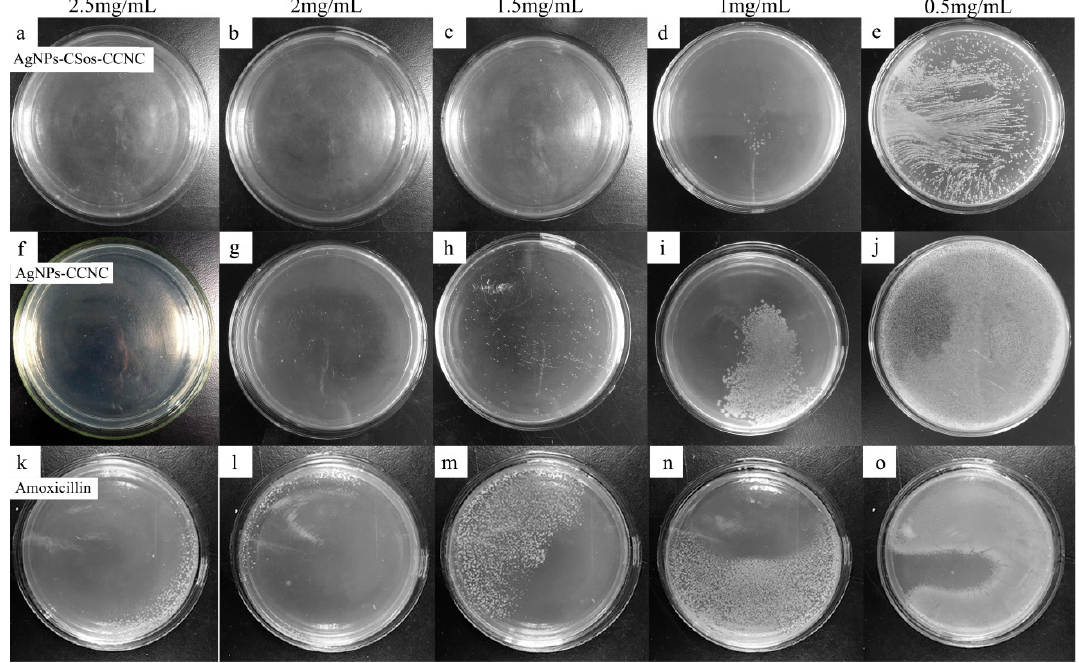
Figure 7. Antimicrobial activity of AgNPs-CSos-CCNC, AgNPs-CCNC and amoxicillin evaluated with S. aureus. The antimicrobial agent concentrations were shown on the top of each plate. ( a – e ) the colony growth with AgNPs-CSos-CCNC, ( f – j ) the colony growth with AgNPs-CCNC, ( k – o ) the colony growth with amoxicillin.